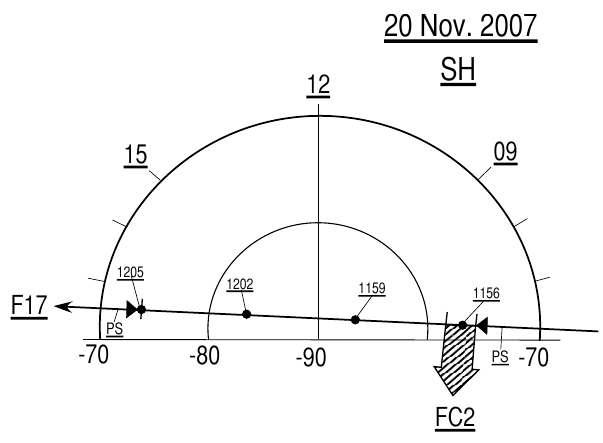
Fig. 16. Track of spacecraft DMSP F17 during the interval 11:56– 12:05UT shown in MLT/MLAT coordinates. Flow channel FC 2 at dawn is